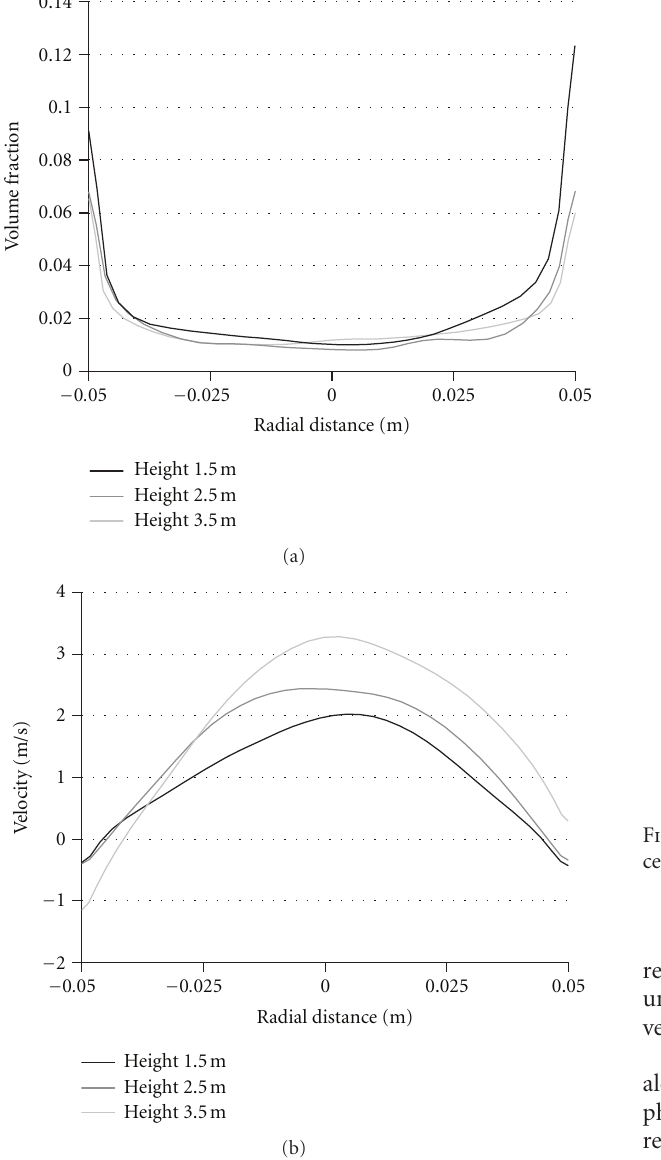
Figure 8: CFD simulation solid phase mean radial profiles of (a) volume fraction; (b) axial velocity component at 1.5m, 2.5 m, and 3.5m.